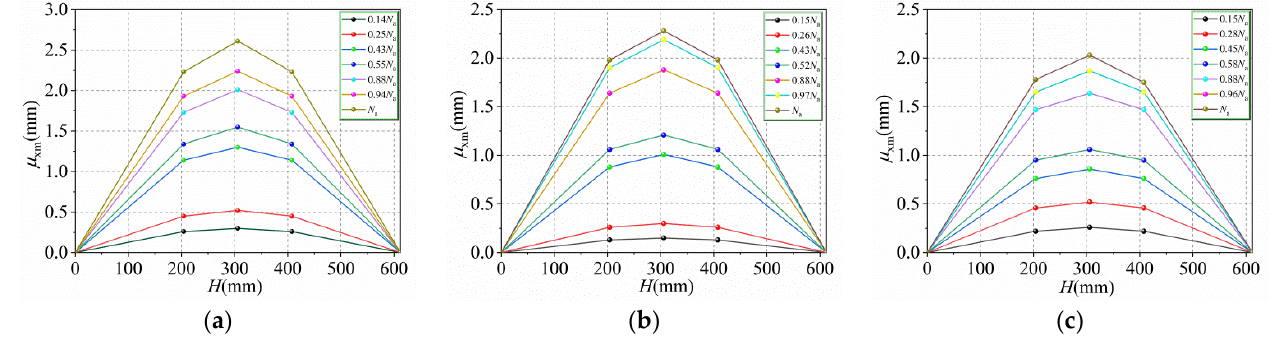
Figure 13. Lateral deflection curves for three typical specimens: ( a ) HUCFEST-18 （ e = 40 mm); ( b ) HUCFEST-19 （ e = 50 mm); ( c ) HUCFEST-20 ( e = 60 mm).